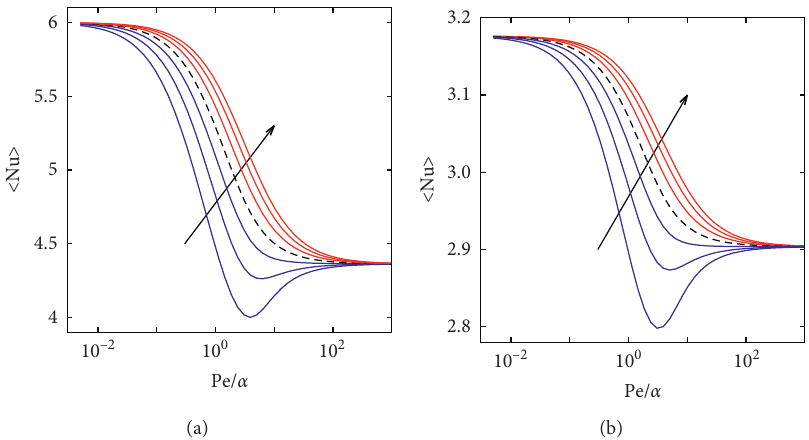
Figure 10: Upper bound 〈 Nu q ( ζ ) � 1. w